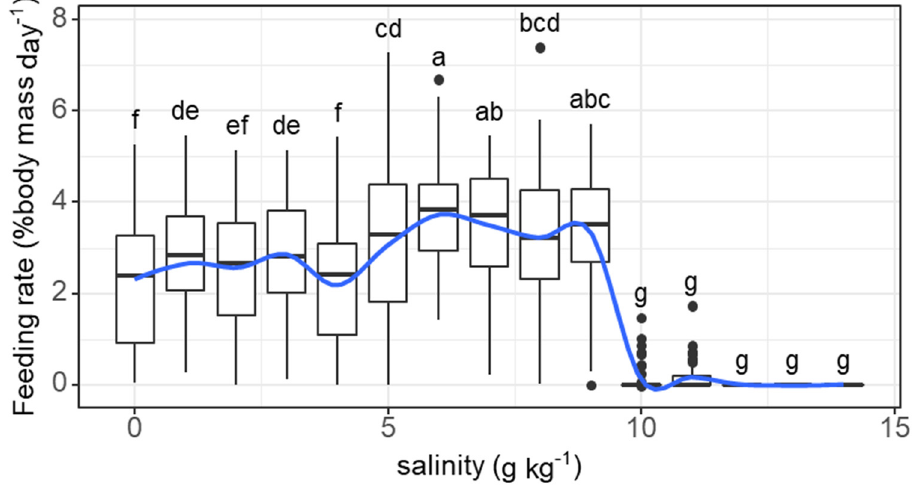
Figure 1. Variations in the feeding rate (% body mass day − 1 ) of grass carp with daily increasing salinity (g kg − 1 ). The data are expressed as boxplots, with boxes indicating the upper, middle, and lower quartiles, and vertical lines indicating the upper whisker and lower whisker. The blue curve describes the changing tendency using locally weighted scatterplot smoothing (LOWESS). a–g: Boxes without common superscripts indicate significant differences among salinities ( p < 0.05). Black dot: the